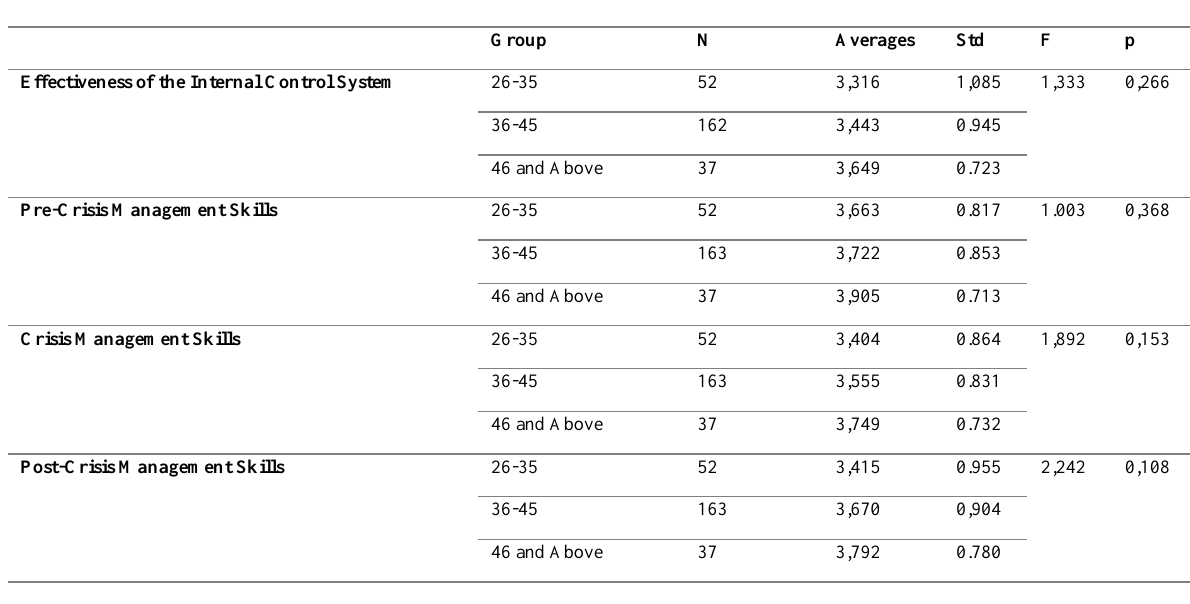
Table 9: ANOVA Differentiation Status of Participants' Effectiveness of ICS and Crisis Management Skill Scores According to Their Age